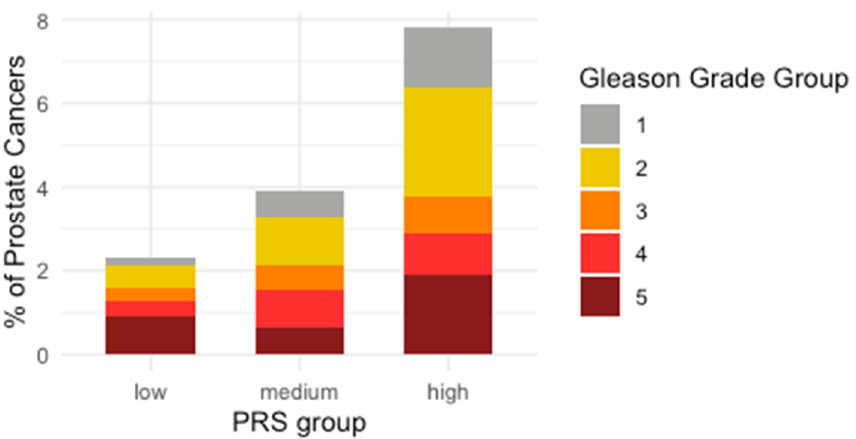
Figure 2. Gleason grade in incident prostate cancer stratified by polygenic risk, showing percentage of prostate cancers in each group, divided by their Gleason grade group. Gleason scores were retrieved from 191 individuals. Scores from the primary and secondary foci were combined together to report the Gleason grade group (Table 2, Figure 1). Gleason grade group 2 was the most commonly diagnosed across the cohort. There was no evidence of enrichment of Gleason grade groups across PRS categories (chisq = 8.5, df = 8, p = 0.37).